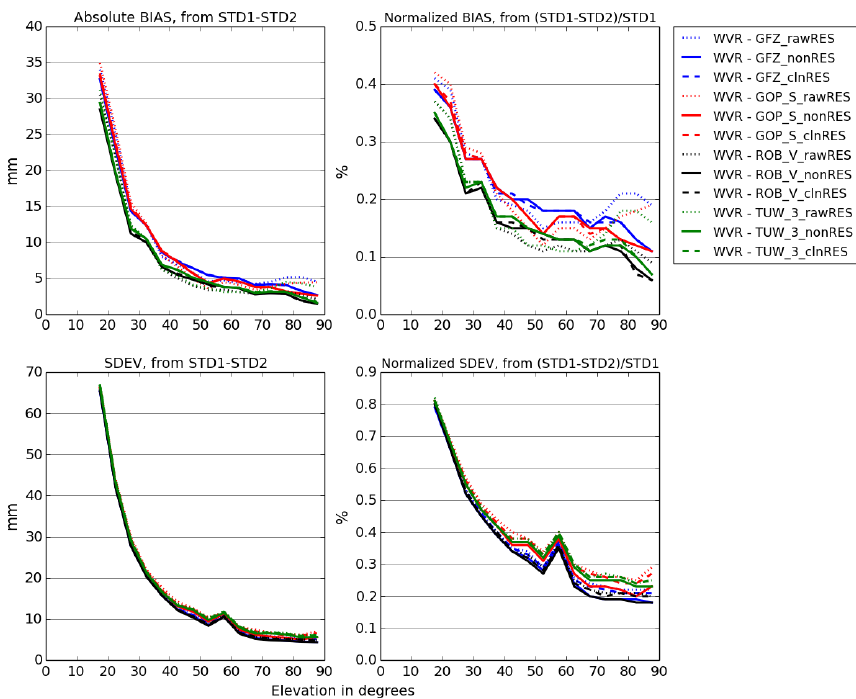
Figure 11. Comparison of WVR against individual GNSS STD solutions at station POTS, in the slant direction. Table 6. Characteristics of individual dual stations. Dual station Location Horizontal Vertical Identical Identical Pairs of distance distance type of type of